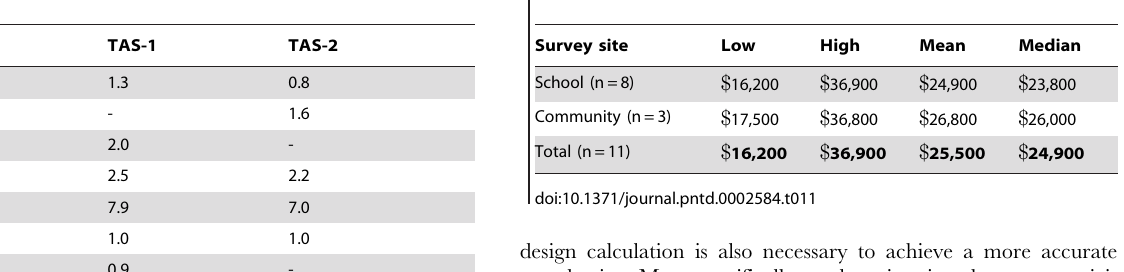
Table 9. Design effects calculated for TAS-1 and TAS-2 cluster surveys.